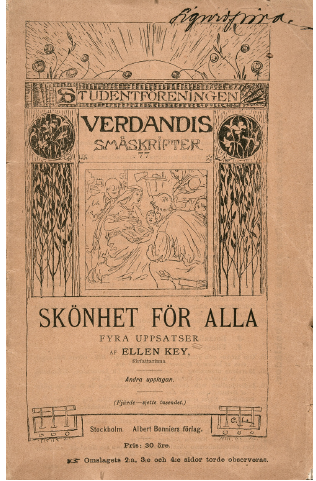
Figure 3. Ellen Key (1849–1926): Skönhet för Alla (“ Beauty for Everyone ”), Stockholm 1899. Cover by Carl Larsson (1853–1919).